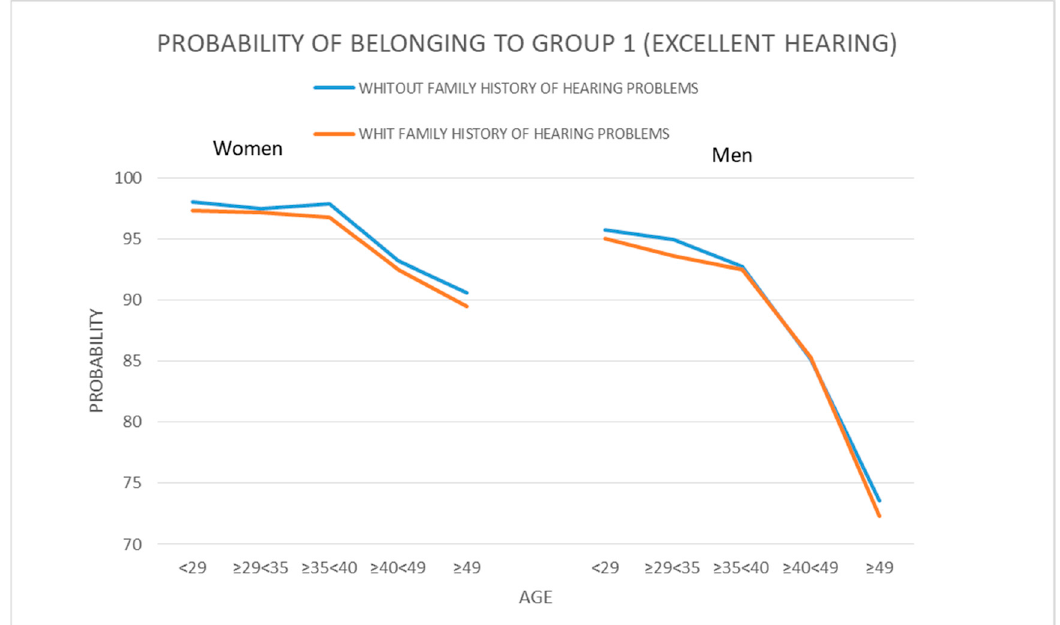
Figure 4. Graph comparing the probability of excellent hearing by gender, age, and family history of hearing problems. Source: Compiled by